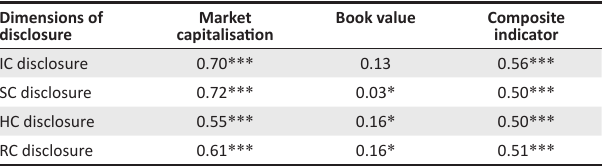
TABLE 3: Correlation matrix of the four constructs of organisational performance ( N = 150). Dimensions of disclosure